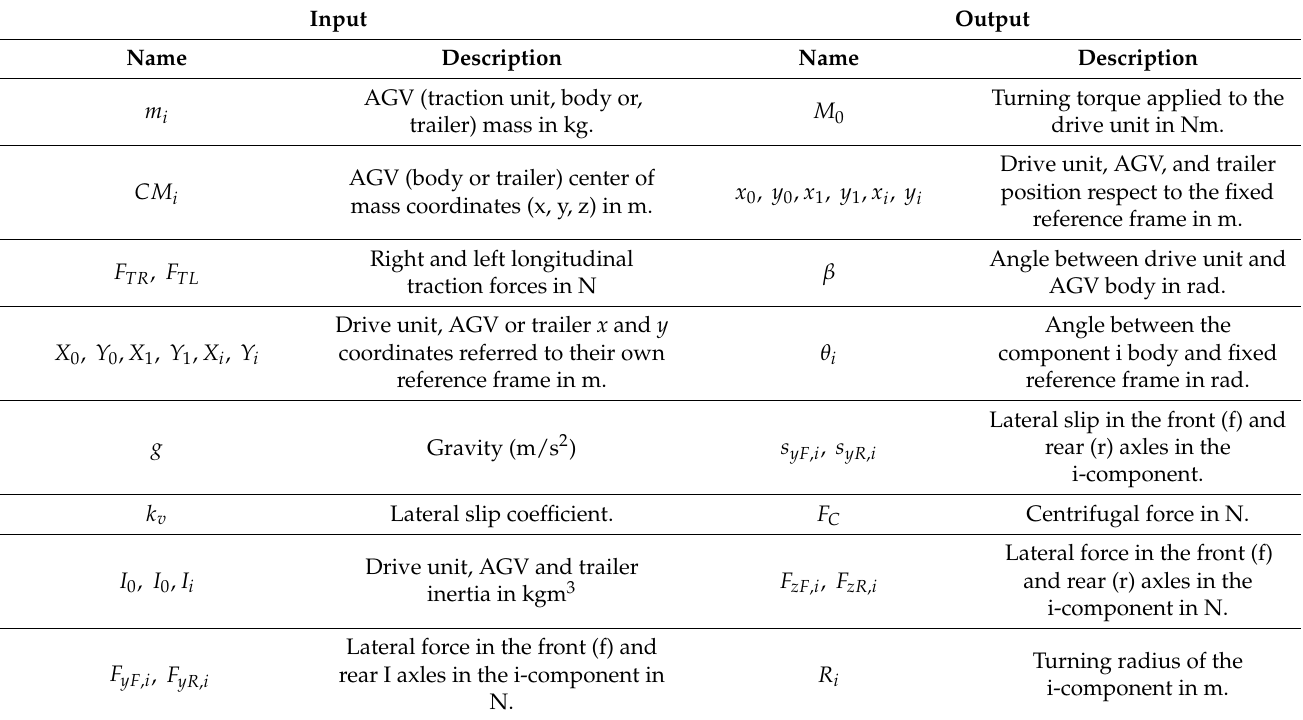
Table 1. Inputs and outputs of the